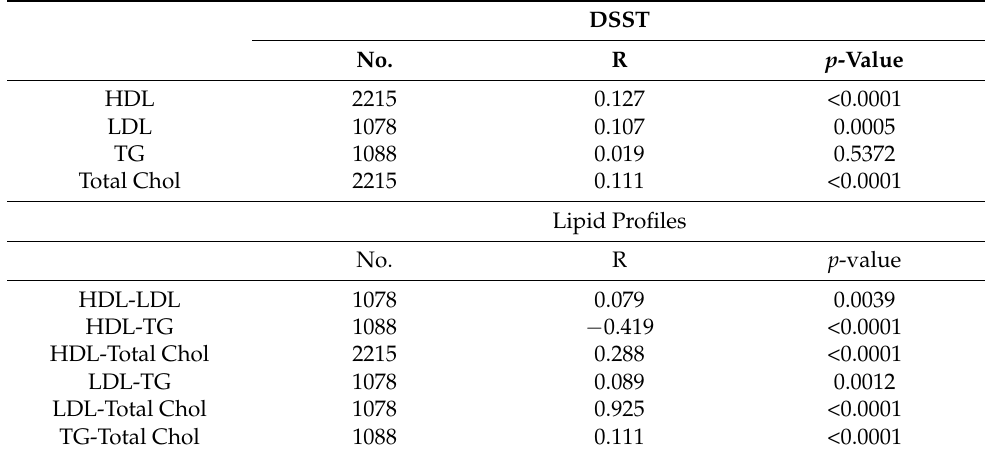
Table 3. Pearson correlation structure of lipid profiles-DSST and among lipid